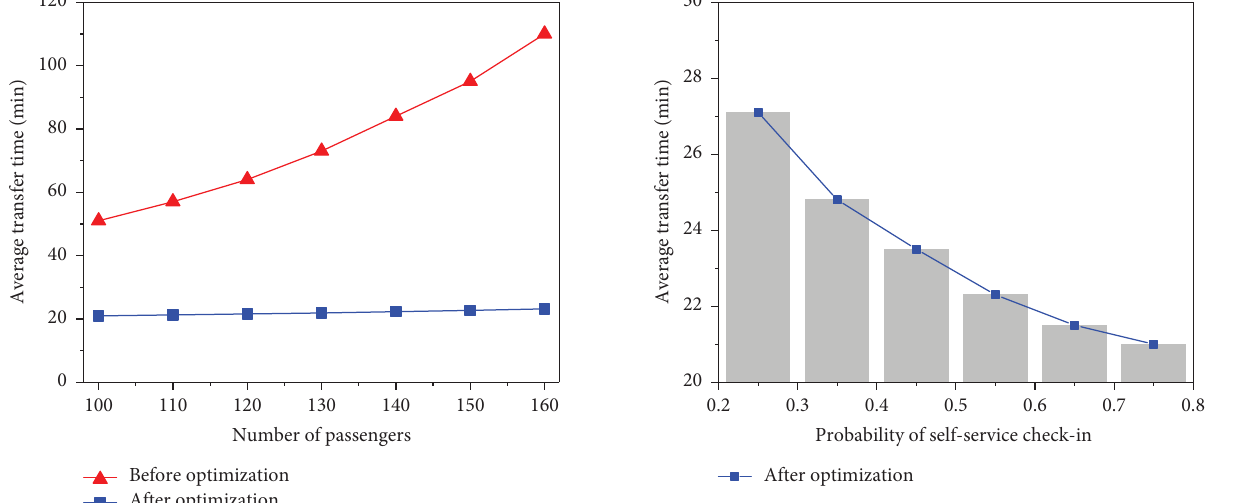
Figure 8: Infuence of probability of self-service check-in on av- erage transfer